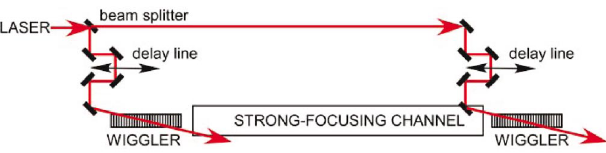
FIG. 2. (Color) A schematic of the laser assisted